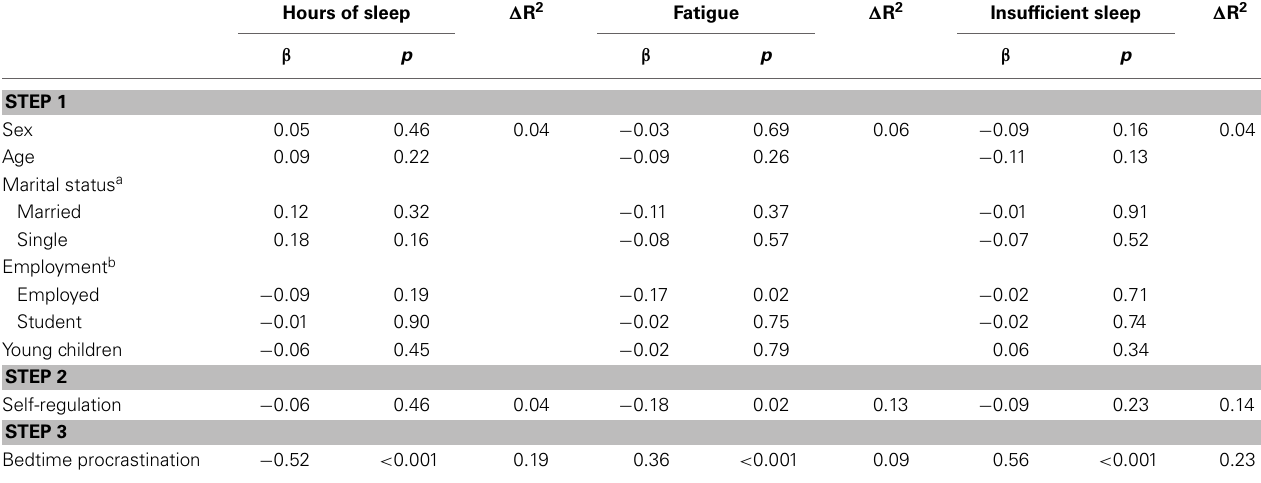
Table 3 | Final regression models for sleep